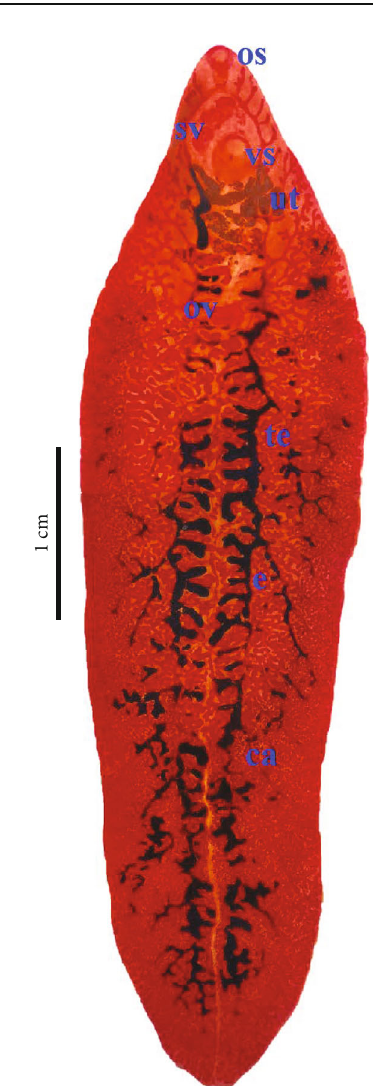
Figure 1: Adult Fasciola gigantica (Semichon ’ s acetocarmine stain); oral sucker (os), seminal vesicle (sv), ventral sucker (vs), uterus (ut), ovary (ov), testis (te), and caecum